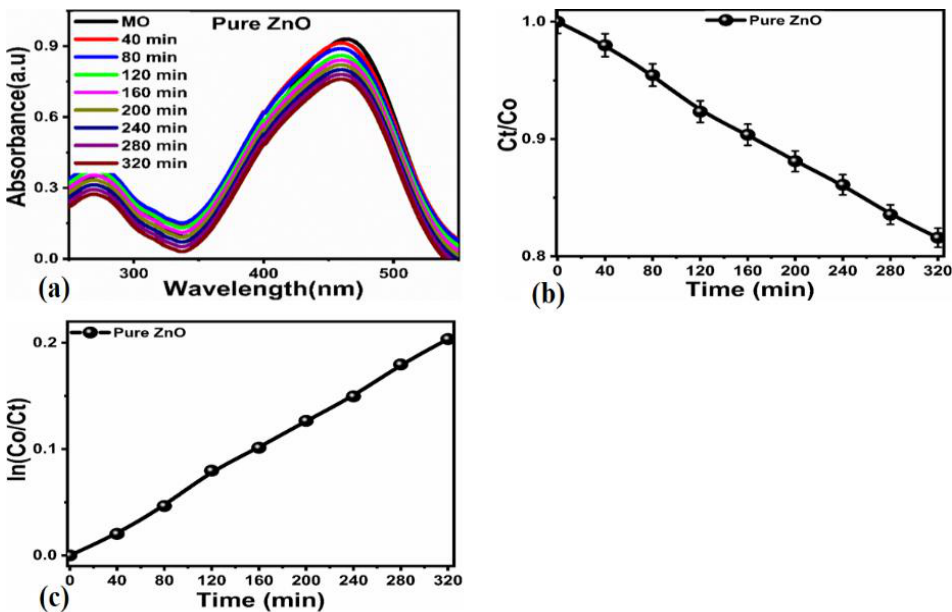
Figure 7. Degradation over time (320 min) of a solution of MO of concentration 2.44 × 10 −5 M under irradiation with UV light, in the presence of 5 mg of pristine ZnO. ( a ) Time change of the UV-vis spectrum, ( b ) kinetics C t / C o irradiation time, ( c ) Ln C t / C o plot of pure ZnO over MO.